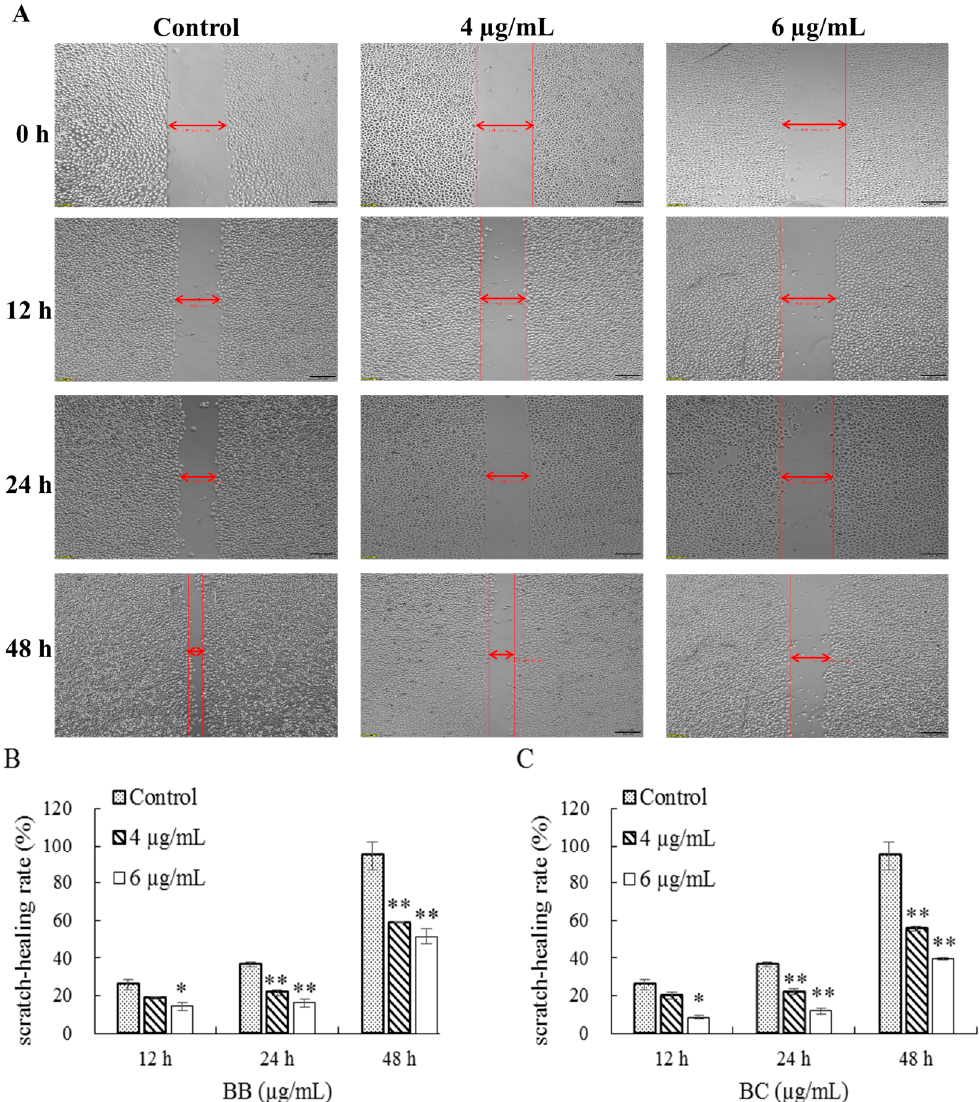
Figure 2. Effect of BB and BC on the inhibition of migration of cancer cell BGC-823: ( A ) the mor- phology of BGC-823 cells after treatment by BB; ( B , C ) the scratch-healing rates of BGC-823 cells after treatment by BB and BC, respectively. The red twin-arrows indicate cell scratch’s length. The data are expressed as the means ± SEs (* p < 0.05; ** p < 0.01).